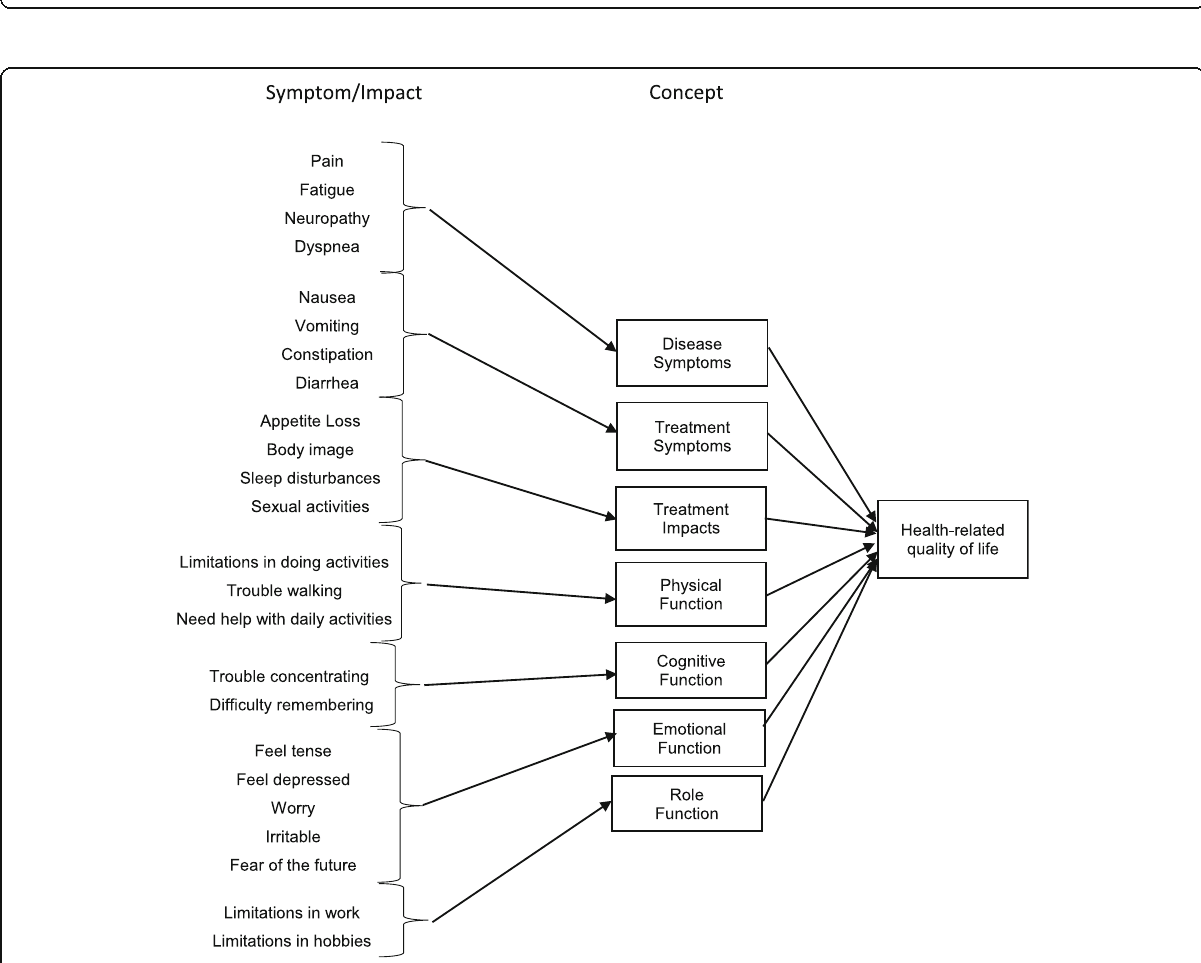
Fig. 1 Data Acquisition process from the Belong.life Patient Powered Research Network